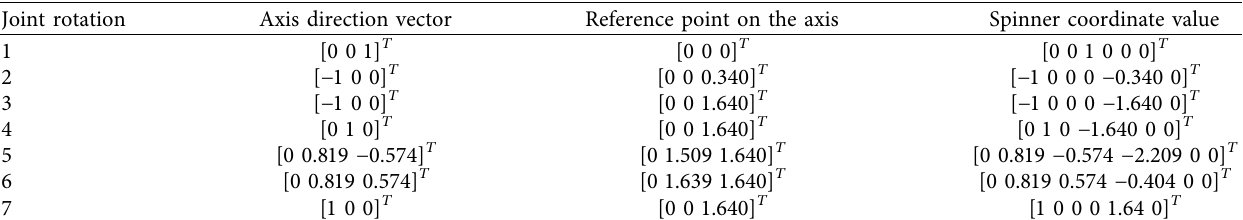
Table 2: Joint parameters of spraying